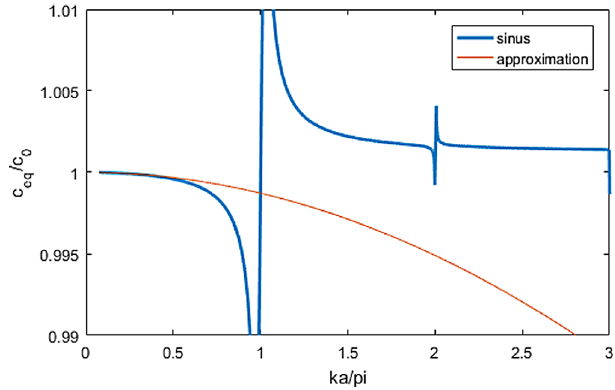
¼ k 0 Figure 4. c eq as a function of kb for sinusoidal linear density p c 0 k eq fl uctuations with (cid:1) l s ¼ 0 : 14 and b = 7.5 cm . Thin red line: l 0 parabolic approximation.